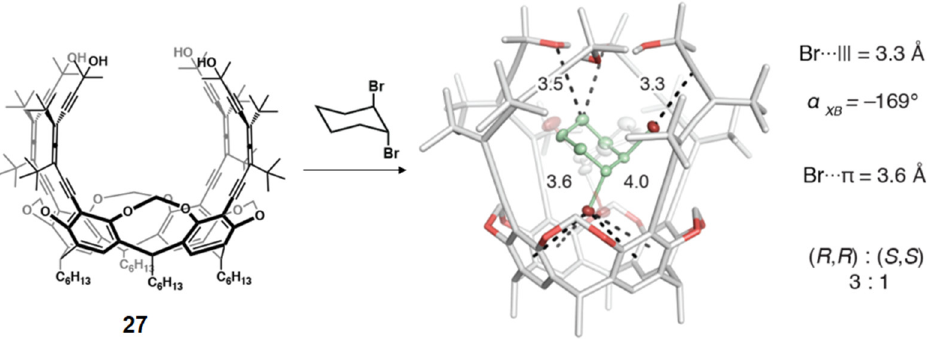
Figure 16. Chiral recognition of trans -1,2-dibromocyclohexane in the diaxial conformation bound to the interior of 27 (Reprinted/adapted with permission from Ref [95]. Copyright 2017, American Chemical Society).